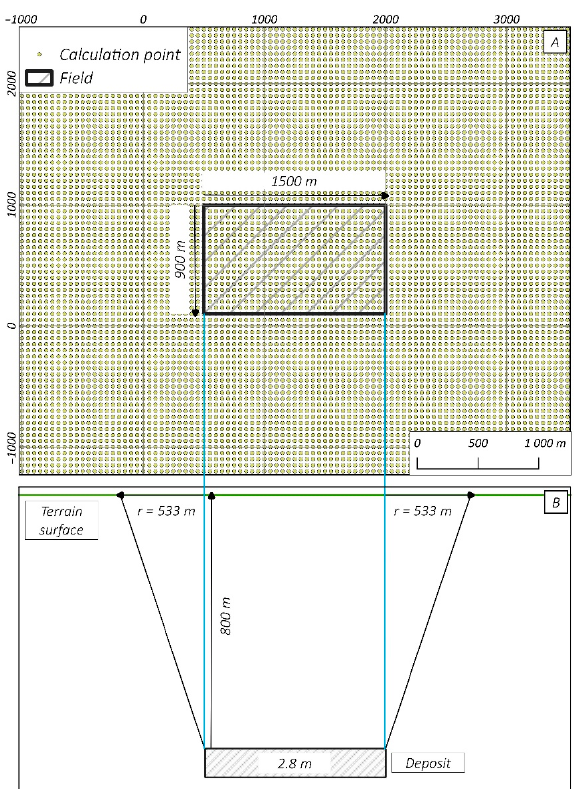
Figure 2. ( A ) 3-D overview of the model data used in the study during the theoretical computational experiment; ( B ) vertical cross-section of the model. Ground movements were analysed in the presented study using data from Sentinel-